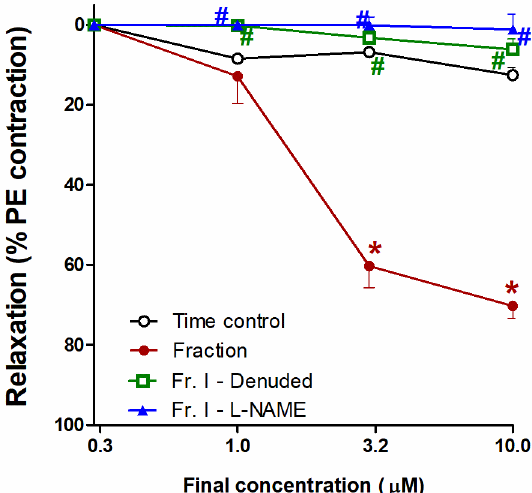
Figure 4. Effect of the H. revolutum chloroform fraction on PE-precontracted separated intact or denuded aorta or aorta preincubated with a nitric oxide synthase inhibitor (L-NAME) compared with time control. Results are introduced as the mean ± standard error of the mean (SEM) ( n = 8). * Significantly varies from the corresponding time control values ( p < 0.05); # Significantly varies from the corresponding chloroform fraction ( p < 0.05) by two-way repeated-measures ANOVA and the Newmans–Keuls posthoc